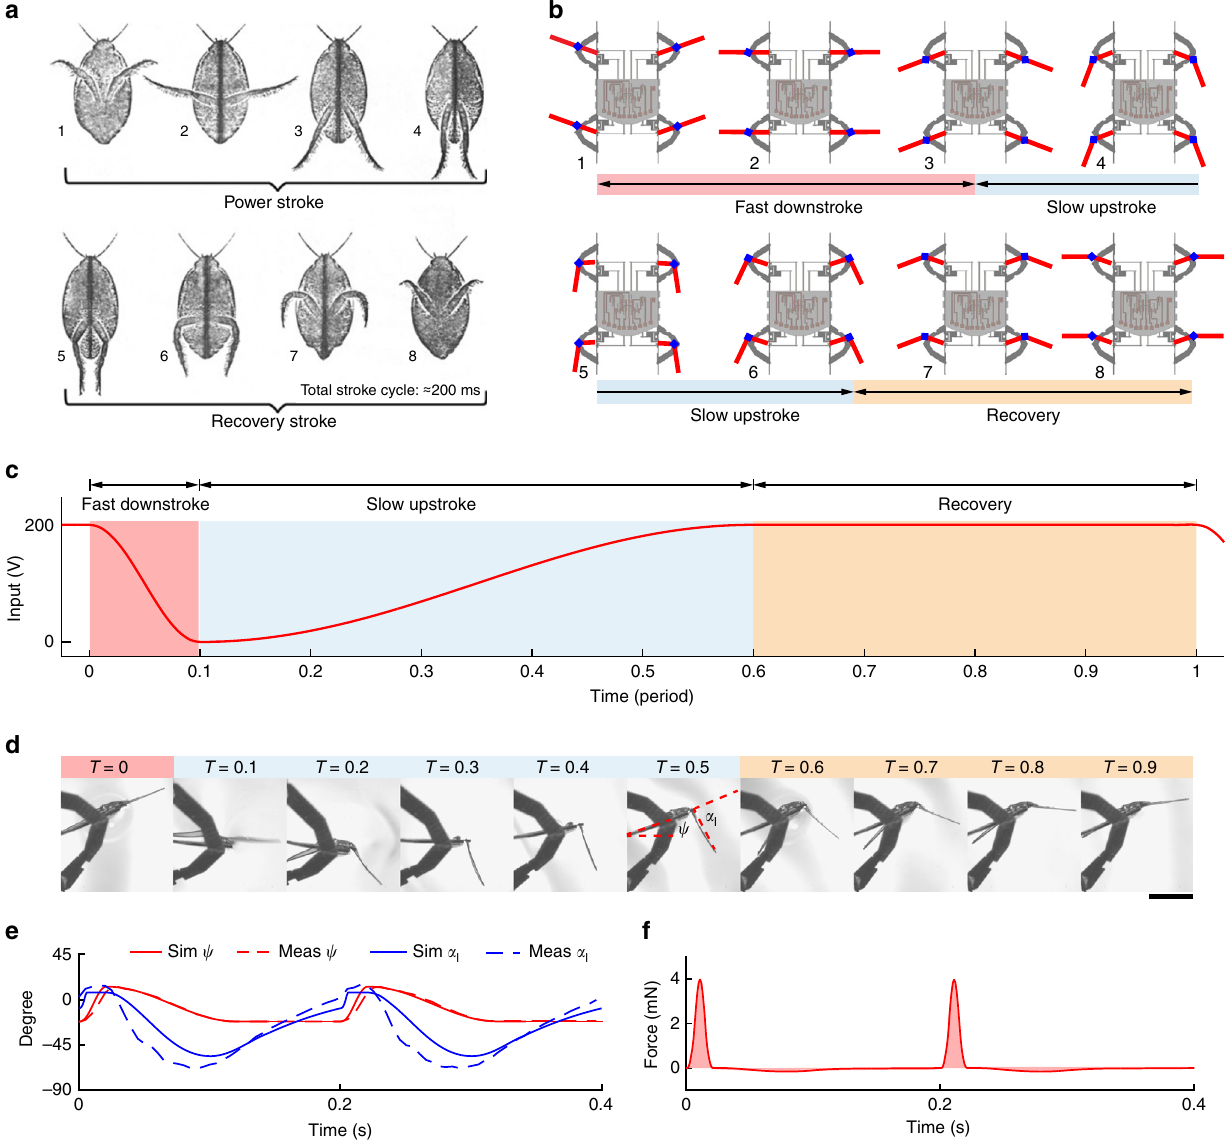
Fig. 4 Aquatic fl apping kinematics and dynamics. a Swimming behavior of a diving beetle. The power stroke and the recovery stroke are asymmetric ( fi gure taken from 7 ). b Bioinspired robot swimming kinematics feature asymmetric upstroke and downstroke without active control of the fl ap rotation. c Periodic control signal of the robot swing actuator is asymmetric. d Images of a single leg ’ s swinging motion and the passive fl ap rotation in water. The images are taken 0.1 period apart, corresponding to the time scale of c . Asymmetric leg swinging motion leads to favorable passive fl ap rotation that increases net thrust. Scale bar, 5 mm. e Comparison of experimentally measured and simulated fl apping motion ψ and passive fl ap rotation α . f Simulated instantaneous thrust force as a function of time. The experiments and simulations shown in c – f use the same control signal. e , f show that the quasi-steady model qualitatively agrees with the experimental result, and it predicts that an asymmetric driving signal generates larger net thrust